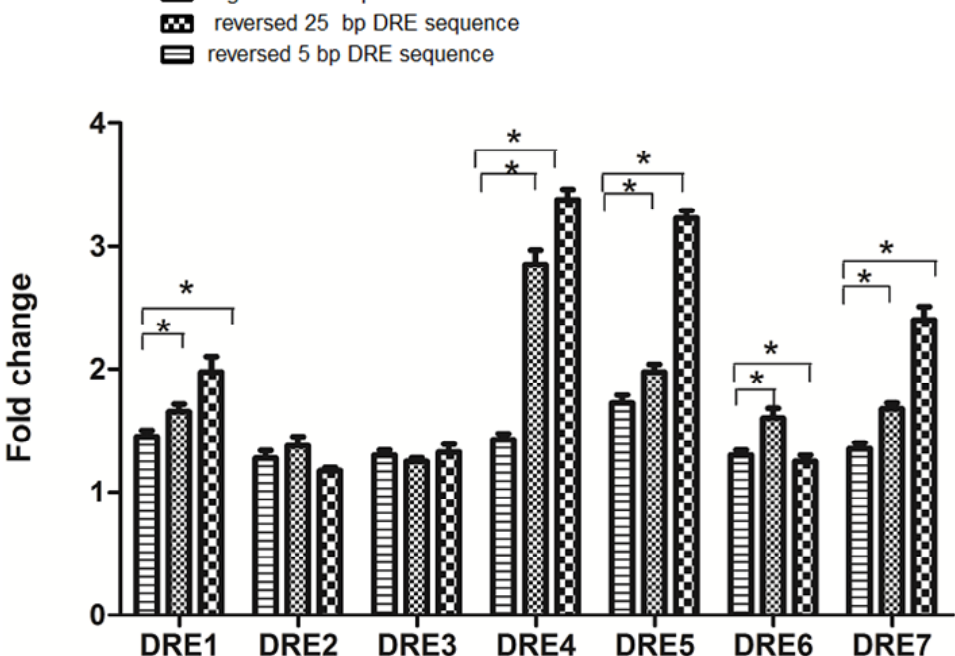
Figure 4. The DRE orientation and its adjacent sequences can affect the efficiency of transcription in response to TCDD. The mouse CYP1A1 promoter-reporter constructs consisting of a 25-bp region surrounding the core DREs in the original orientation, reverse orientation or the reversed core sequence only with surrounding sequences in the original orientation, were transiently transfected into cultured Hepa WT cells. The pGL3-promoter vector is used as the control. One day later, the transfected cells were incubated with TCDD (10 − 9 M) or with solvent alone at 0.1% (control) for one day, followed by luciferase assays to determine the promoter activity. * p < 0.05, the difference from solvent-treated cells (control) by one-way ANOVA with Tukey’s